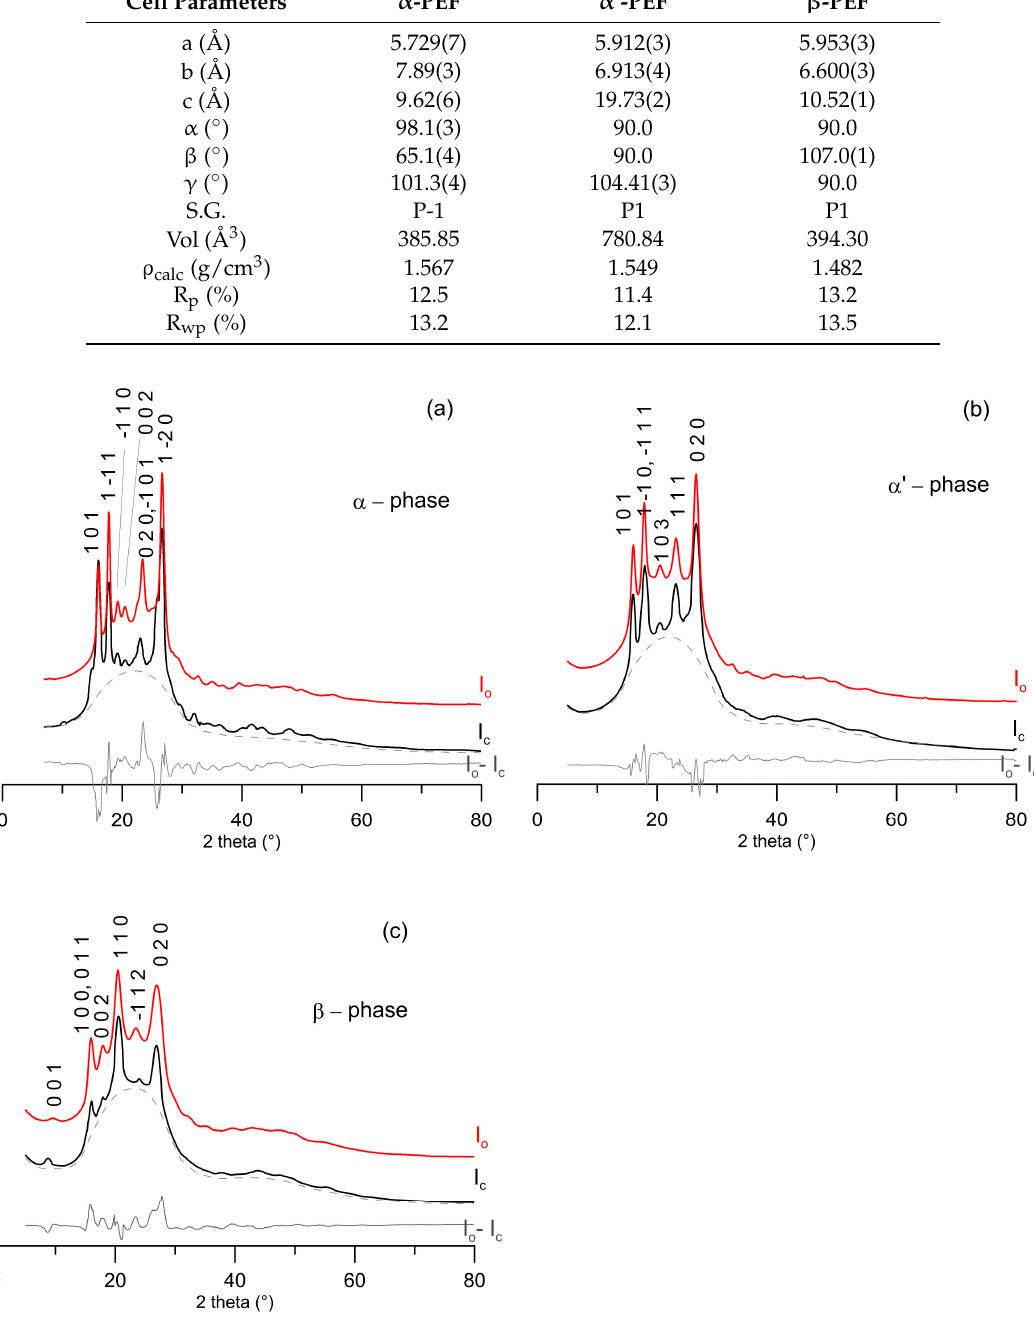
Figure 2. Comparison between observed (red), calculated (black), and Io-Ic difference (grey) powder-diffraction patterns: ( a ) α -PEF; ( b ) α ’-PEF; ( c ) β -PEF. Dashed line (grey) represents the sum of background and amorphous phase contributions. The Miller indices of the reflections that mainly contribute to the peak intensities are reported.